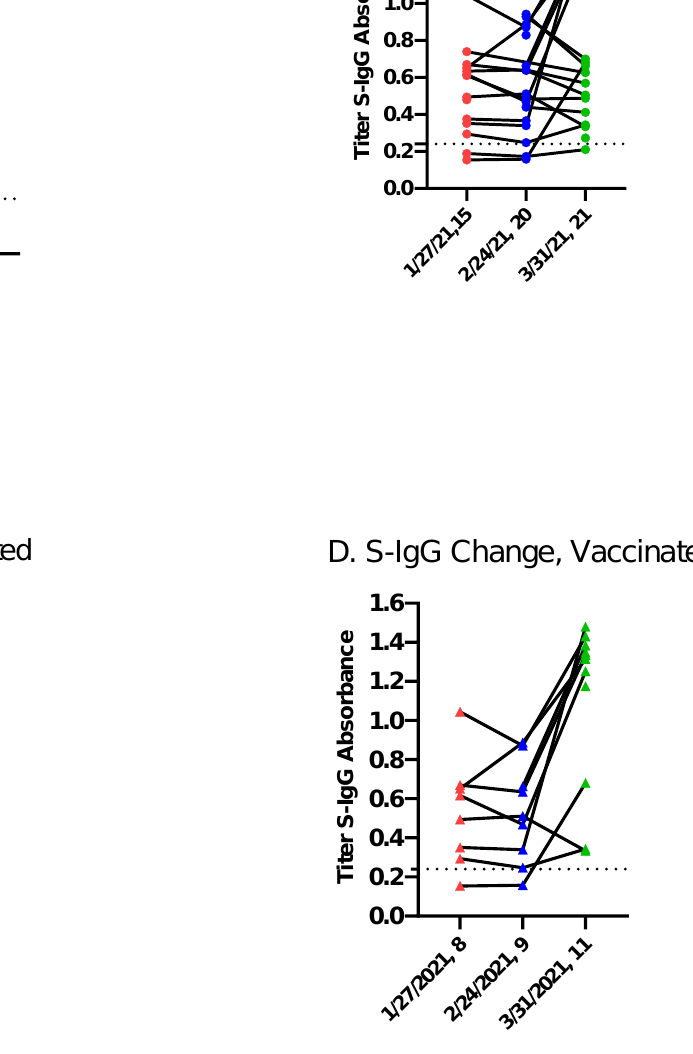
Figure 4. Anti-spike (S-IgG) change at three time points (January, red; February, blue; March green, respectively), and number of student sera at each time point. ( A ) Box and whisker plot by collection date for all students. ( B ) Line graph for change in S-IgG titer at three time points. ( C ) Box and whisker plot among vaccinated students that are a subset of graph ( A ). ( D ) Line graph for change in S-IgG among vaccinated students that are a subset of graph ( B ). One student was first vaccinated on 27 January 2021 and ten were first vaccinated after 2 March 2021.